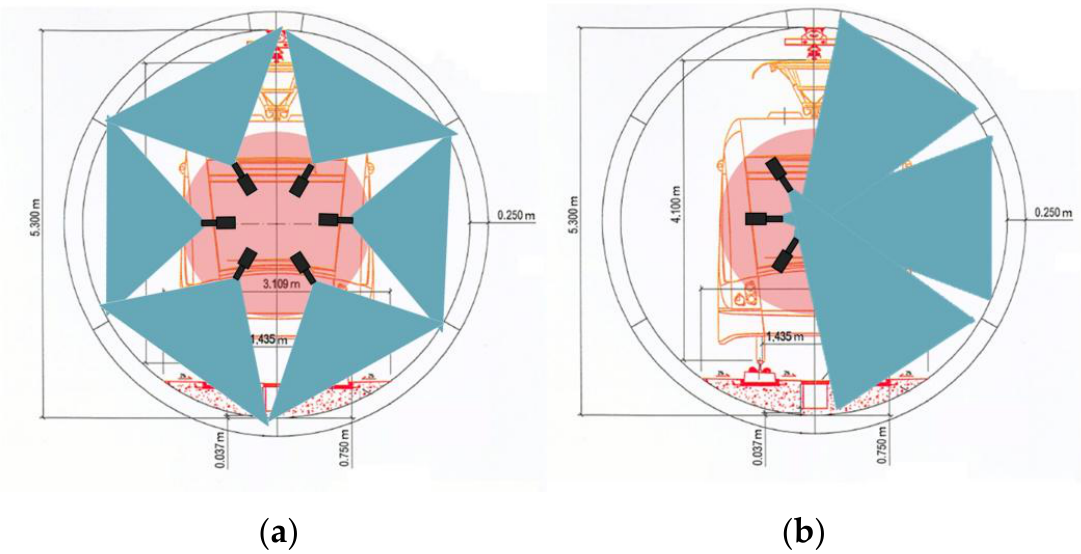
Figure 3. Two examples of camera position distribution, and the portion of the tunnel section covered by each camera. (The field-of-view of the cameras is shadowed in blue). ( a ) Working distance ( W D ) is smaller than the radius of the tunnel ( R T ) ( b ) Working distance ( W D ) is greater than the radius of the tunnel ( R T ), so only half of the cameras can be placed in the same